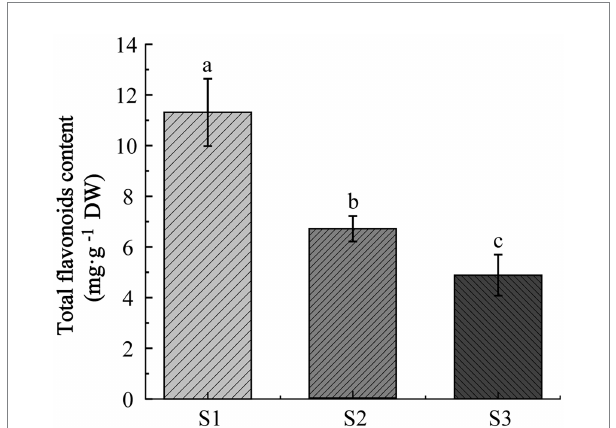
FIGURE 1 Determined the total content of flavonoids in chayote fruits at three storage stages (S1 ~ S3). Error bars represented ±SD. Different lower- case letters indicate a significant difference between group means ( p < 0.05). S1, optimal harvest stage; S2, 15 days after storage; S3, 30 days after